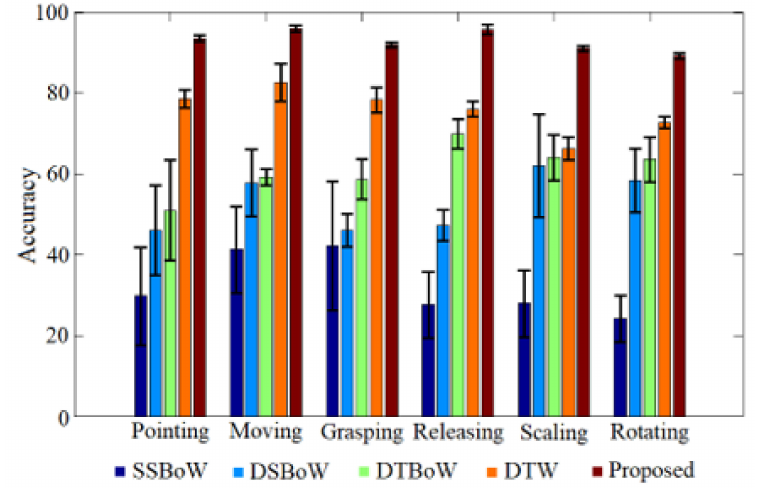
Figure 16. Accuracy of action boundary segmentation on HoloLens ARAAT